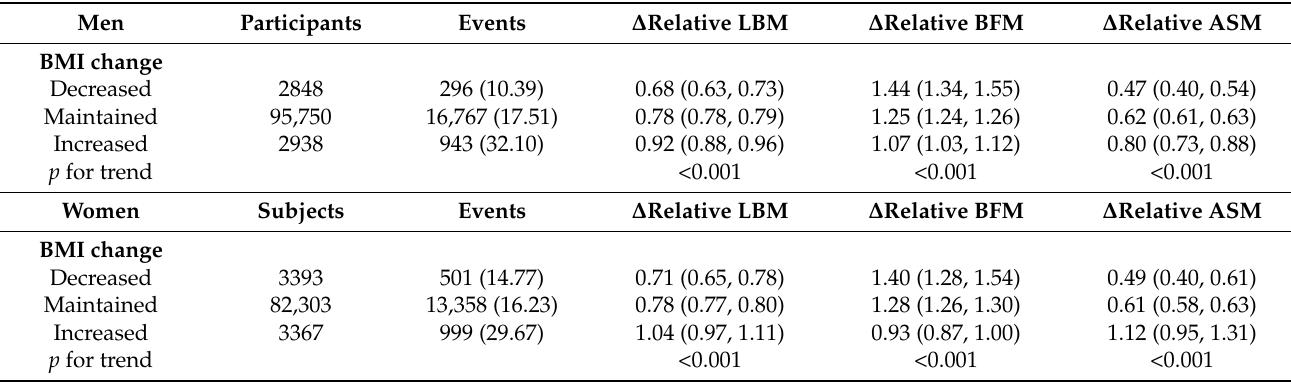
Table 5. Adjusted odds ratios and 95% confidence intervals for metabolic syndrome according to multiple predictors (1% increments) and body mass index